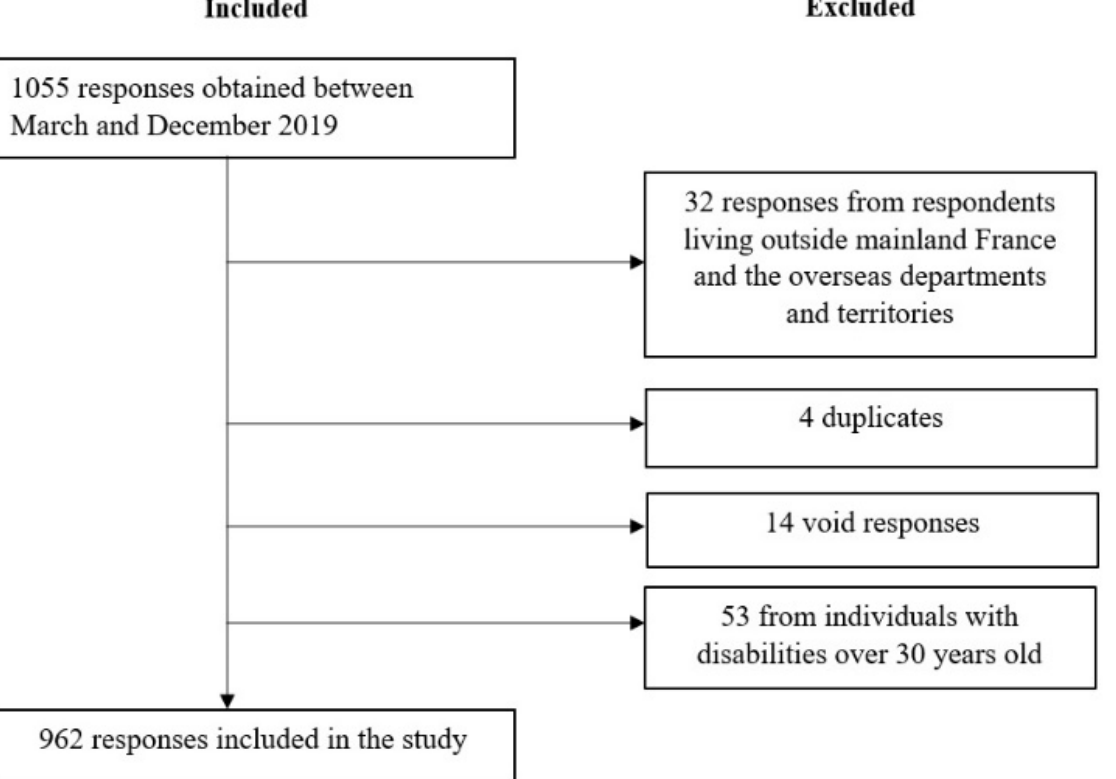
Figure 1. Flow chart.